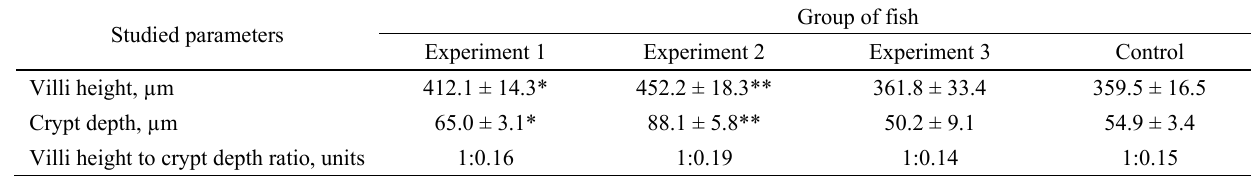
Morphometric parameters of the intestinal mucosa of age -1+ carp fed with the prebiotic additive ( М ± m, n = 4) Studied parameters